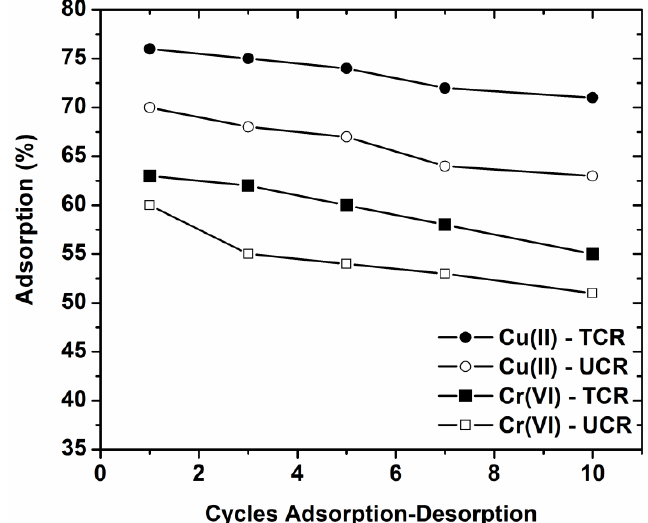
Figure 7. Cycles of adsorption-desorption for the reuse of untreated coffee as adsorbents for Cu(II) and Cr(VI)